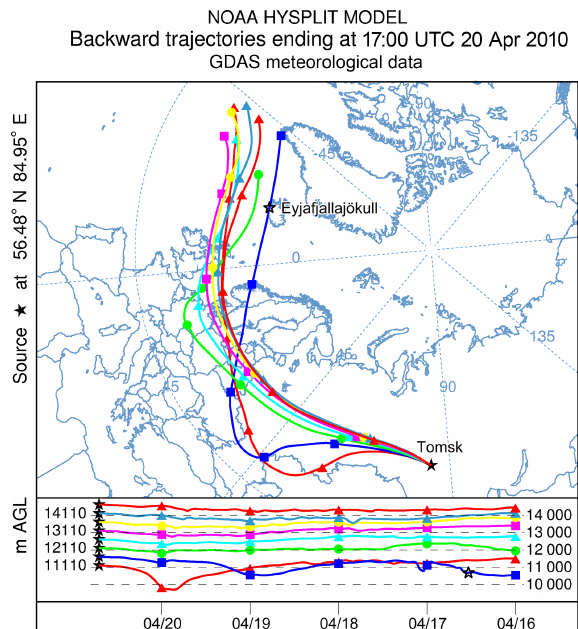
Figure 11. Air mass backward ensemble trajectories started from altitudes of ∼ 11.1–14.6kma.s.l. over Tomsk on 21 April 2010 at 00:00LT (20 April, 17:00UTC) and passed over or south of Eyjaf- jallajökull volcano.